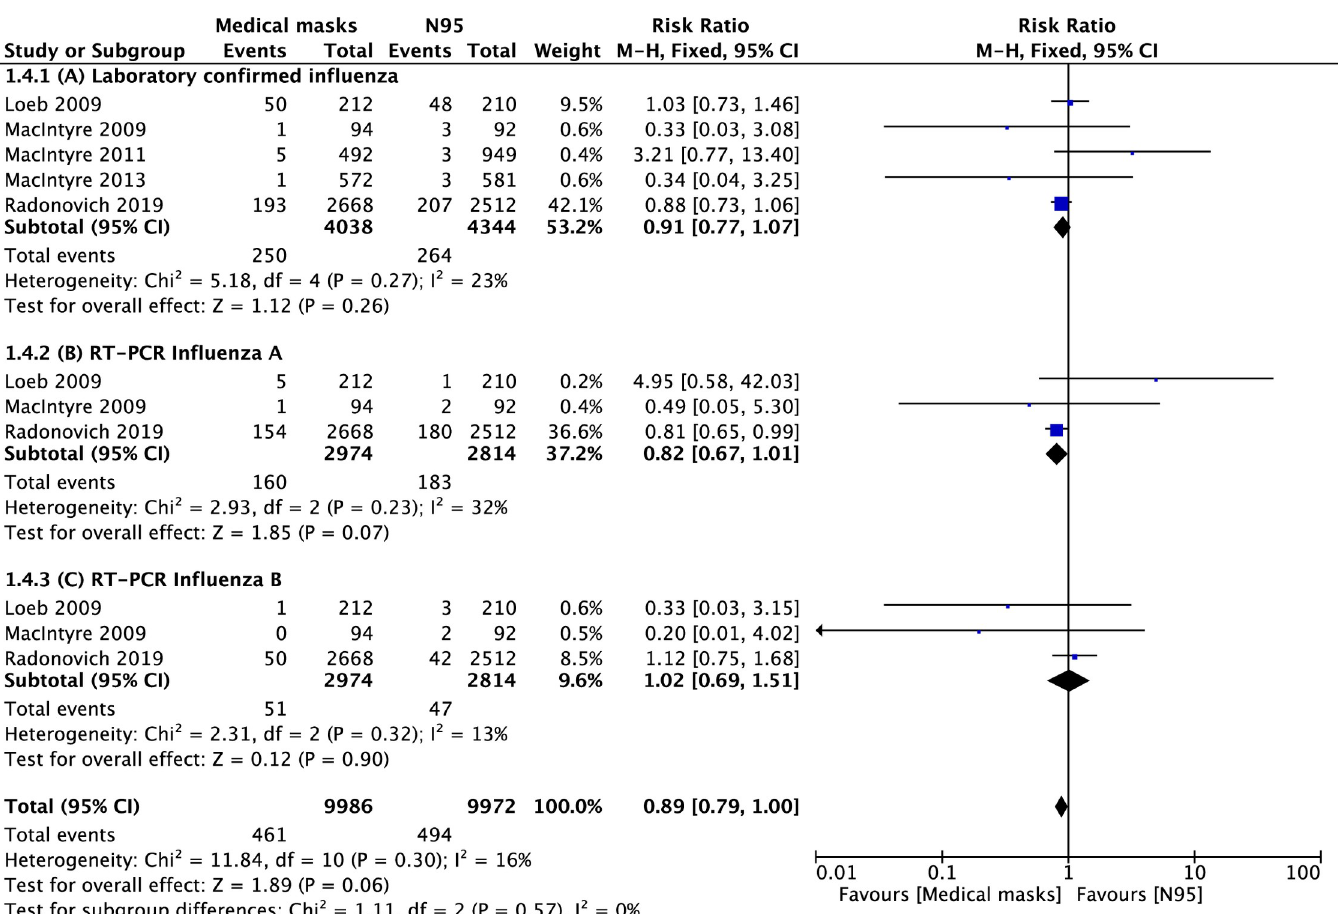
Fig 2. Forest plot of : (2A) laboratory confirmed influenza in medical masks vs. N95 groups; (2B) laboratory confirmed influenza A; (2C) laboratory confirmed influenza B. The center of each square represents the weighted mean difference for individual trials, and the corresponding horizontal line stands for 95% confidence interval. The diamonds represent pooled